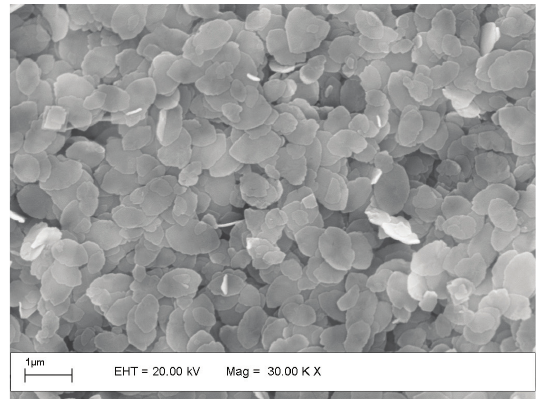
Figure 2. Scanning Electronic Microscopy of WO